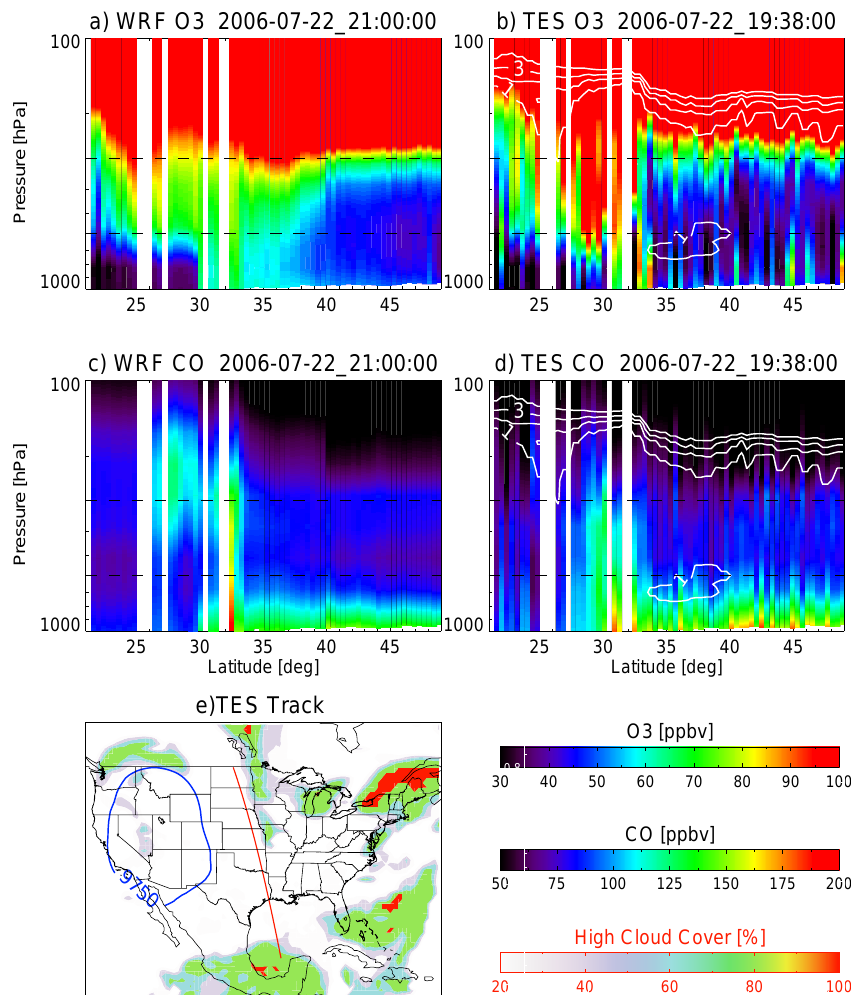
Fig. 6. O 3 ( a and b ) and CO ( c and d ) from the WRF-Chem simulation ( a and c ) and the AURA/TES instrument ( b and d ). The horizontal dashed lines mark the 300 and 600hPa levels. Results are plotted along the TES overpass track for 22 July 2006 over the central US as indicated in (e) . The potential vorticity ( b and d ; 1, 2, 3, 4PVU contours plotted), geopotential height, and high cloud cover (e) from the ERA-Interim 00:00UTC analysis are also